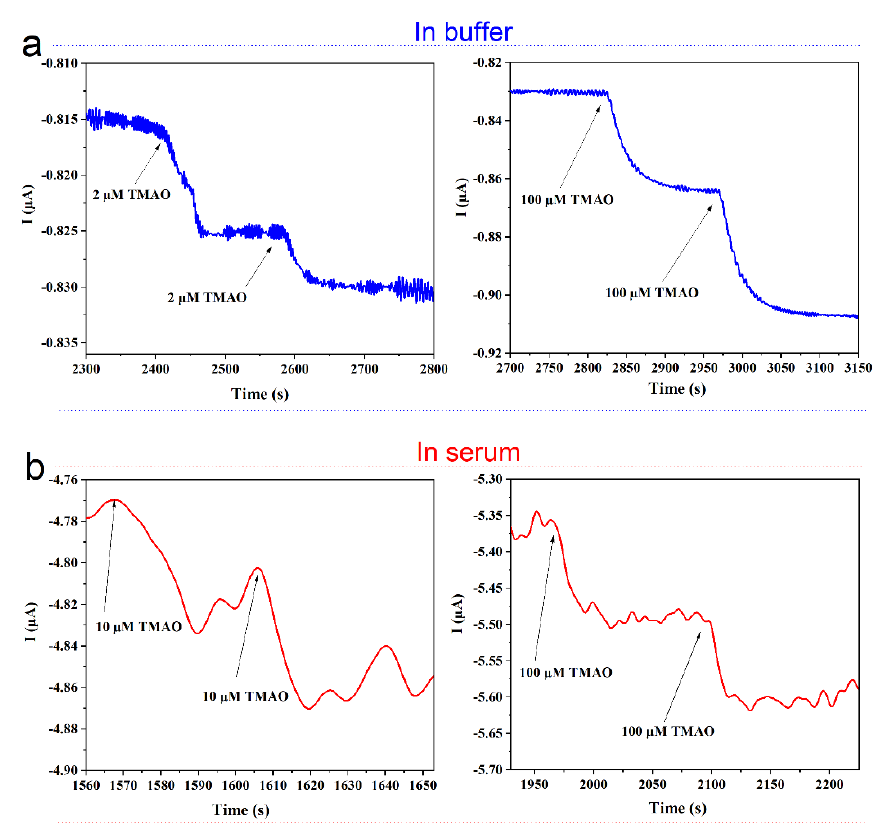
Figure 8. TMAO detection with the optimized TMAO biosensor. Amperometric detection of different concentrations of TMAO ( a ) in buffer and ( b ) in 1:10 diluted serum in buffer. The buffer was a Sörensen phosphate buffer 67 mM pH 7 containing 1 mM MV and 3 mM glucose; the electrode was modified with TorA (5.9 nmol/cm 2 ); GOD 10 U; Cat 1000 U; PVA 3%.